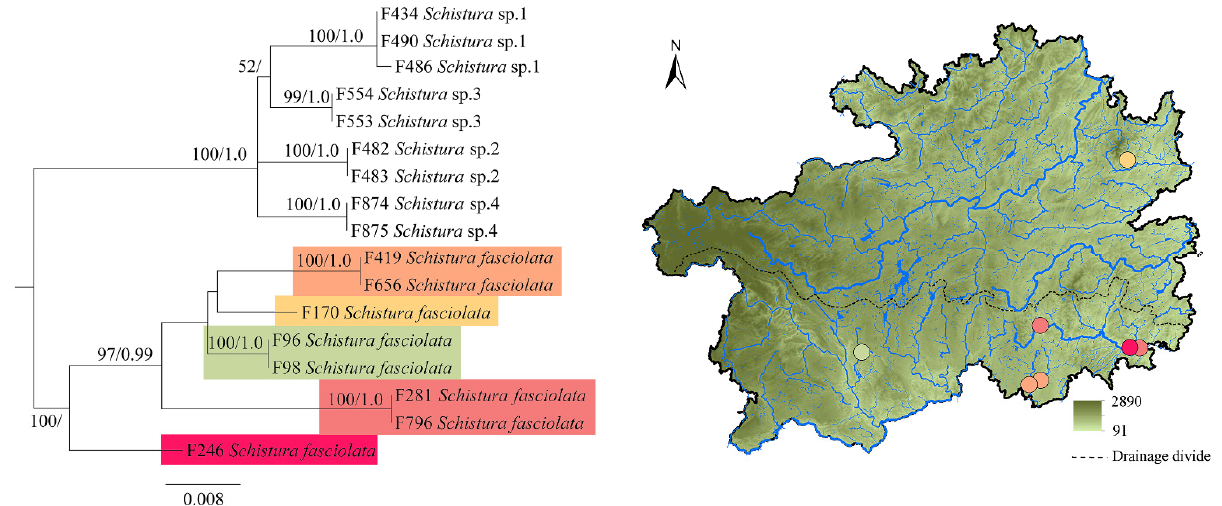
Figure 4. Phylogenetic tree showed cryptic diversity of Schistura fasciolata and collection locations. Results for BI analysis were mapped onto the ML tree. Numbers on the branches are bootstrap percentages (%) from ML and posterior probability from BI. ML with bootstrap >50% and BI with PP >0.5 were shown. The scale bar indicates the number of substitutions per site.